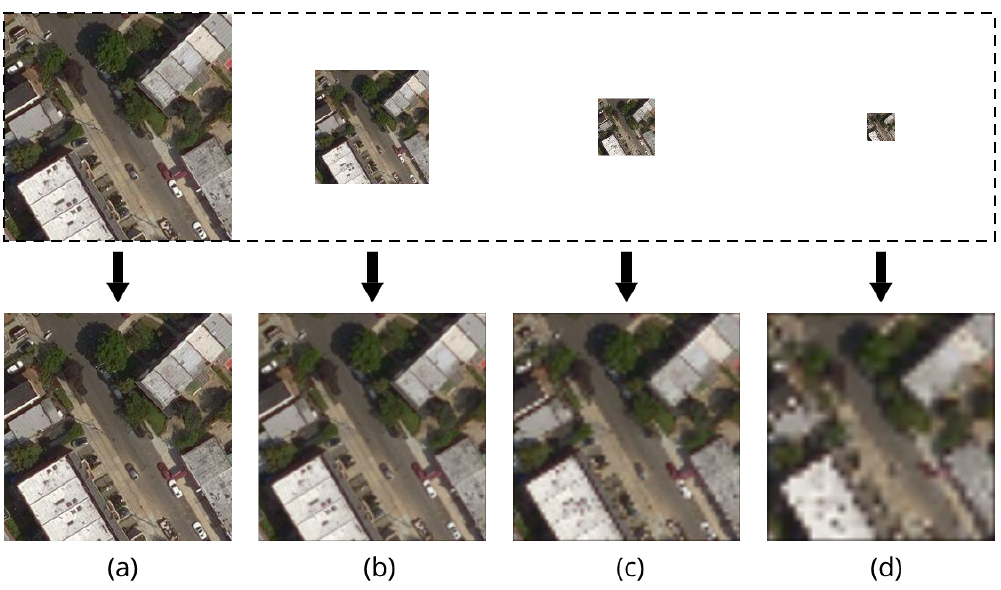
Figure 9. Illustration of an aerial image with different resolutions. ( a ) 256 × 256; ( b ) 128 × 128; ( c ) 64 × 64; ( d ) 32 × 32